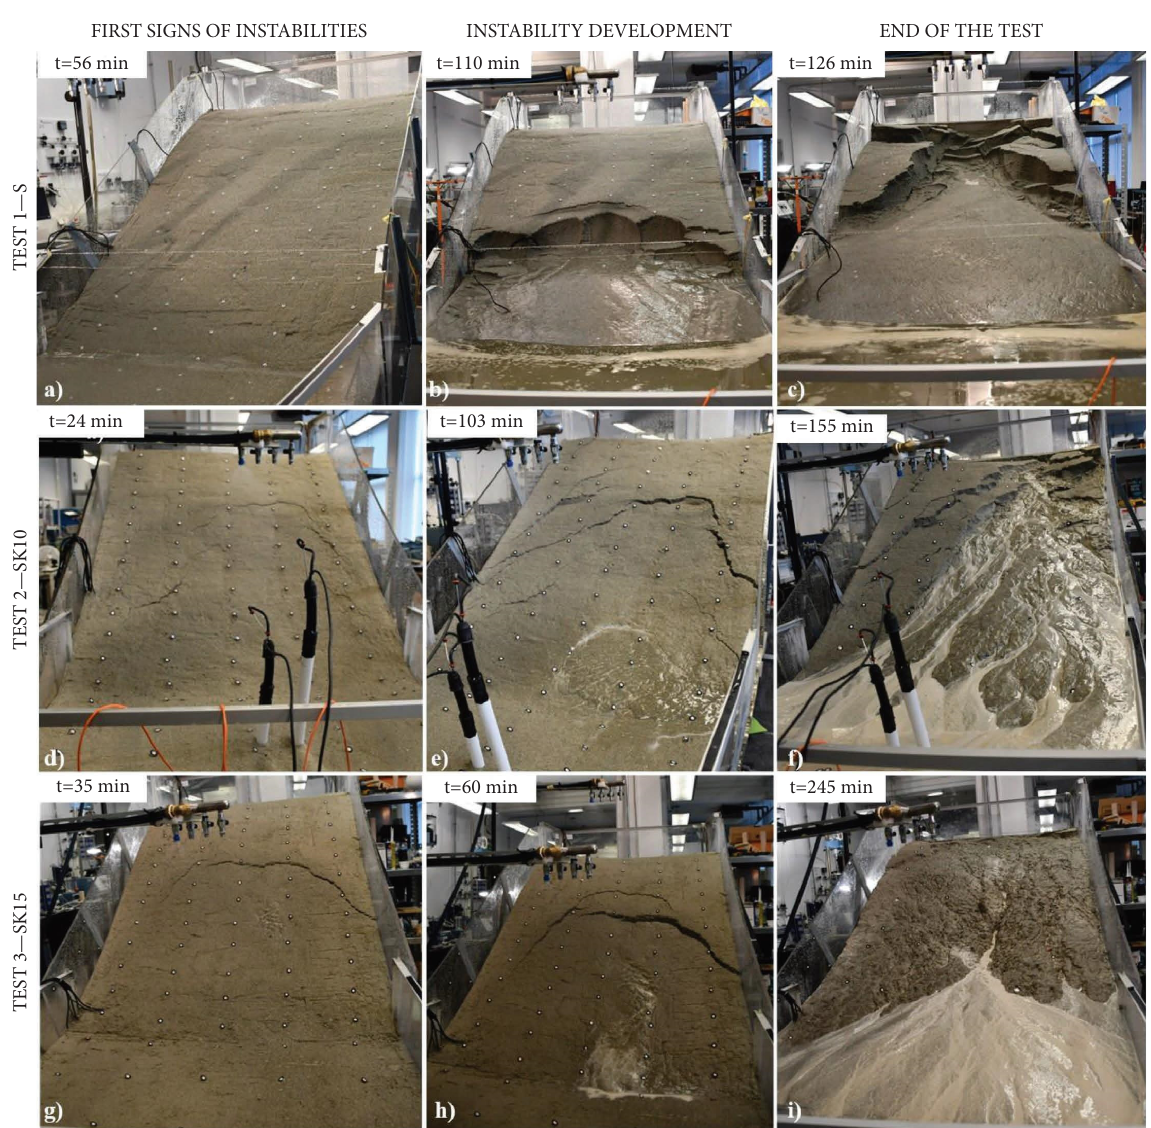
Figure 5: First signs of instability (left), development of instabilities (middle), and conditions at the end of the test (right) for Test 1, Test 2, and Test